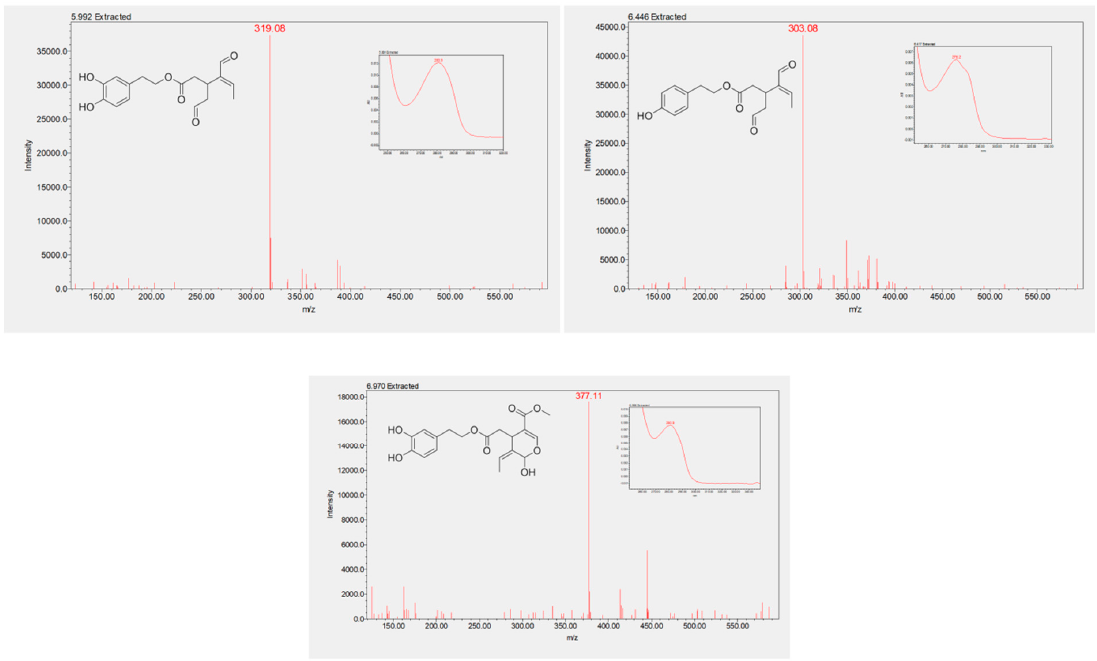
Figure 5. Oleacein ( left ), oleocanthal ( right ) and oleuropein aglycone ( down ) MS − and UV-visible spectra (inset) .